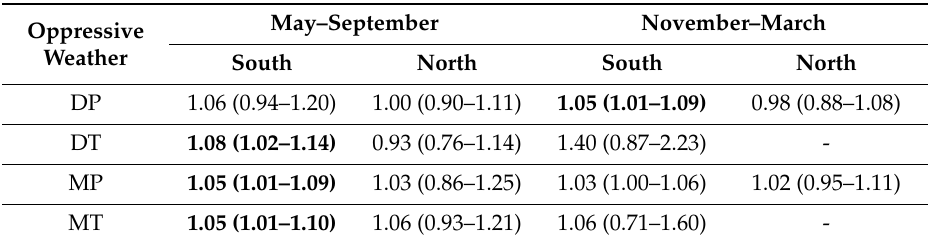
Table 3. Cumulative Relative Risk and 95% confidence intervals for all-cause mortality over 14-days for summer and 28-days for